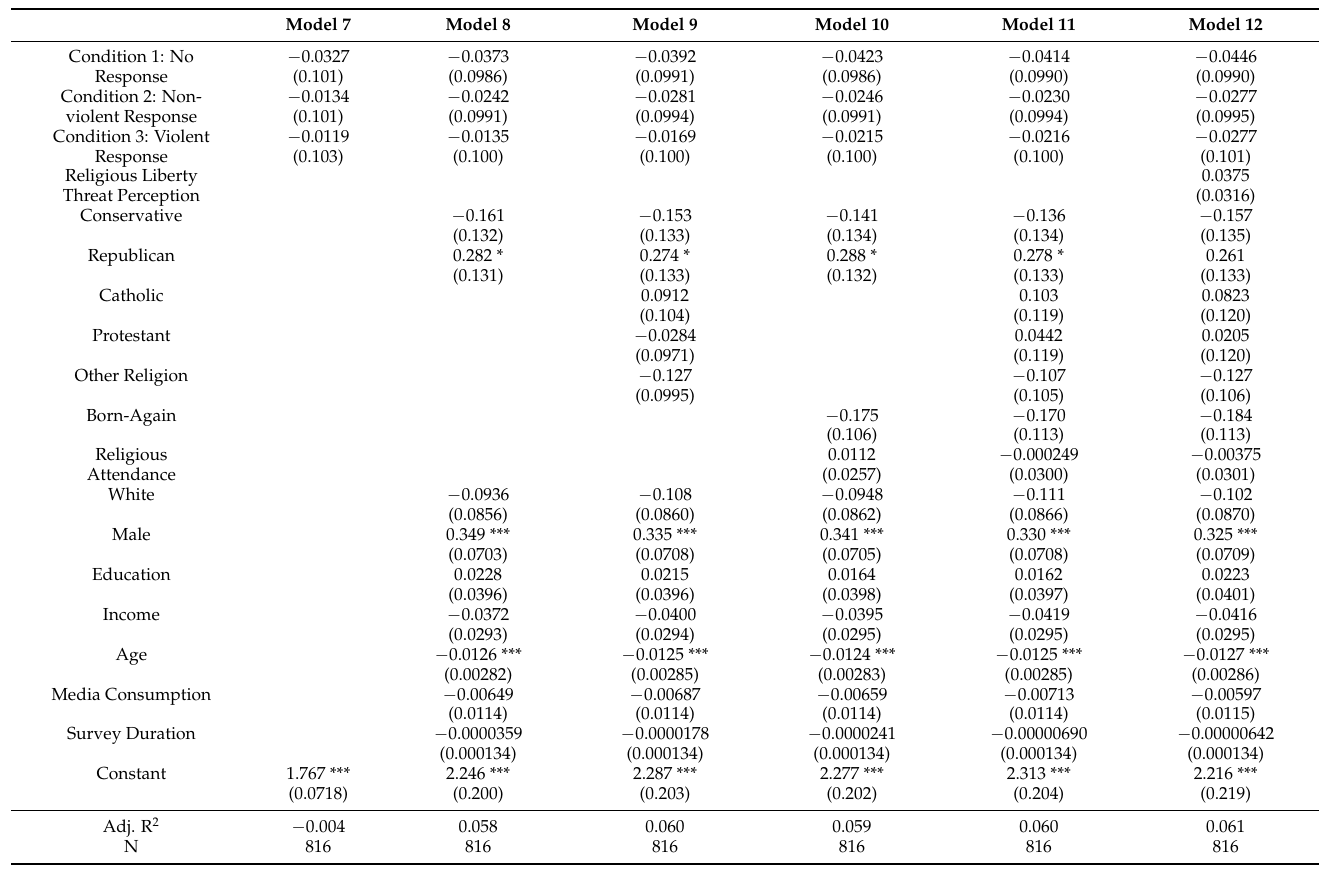
Table 7. Determinants of support for political